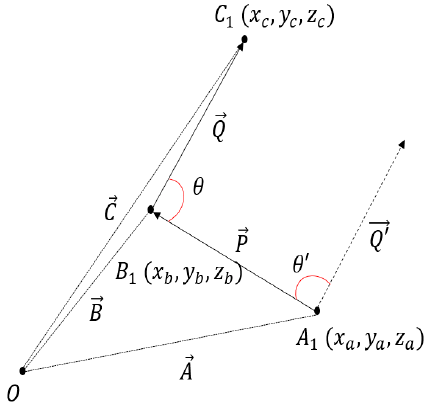
→ → P and Q (cid:48) for degree of bending